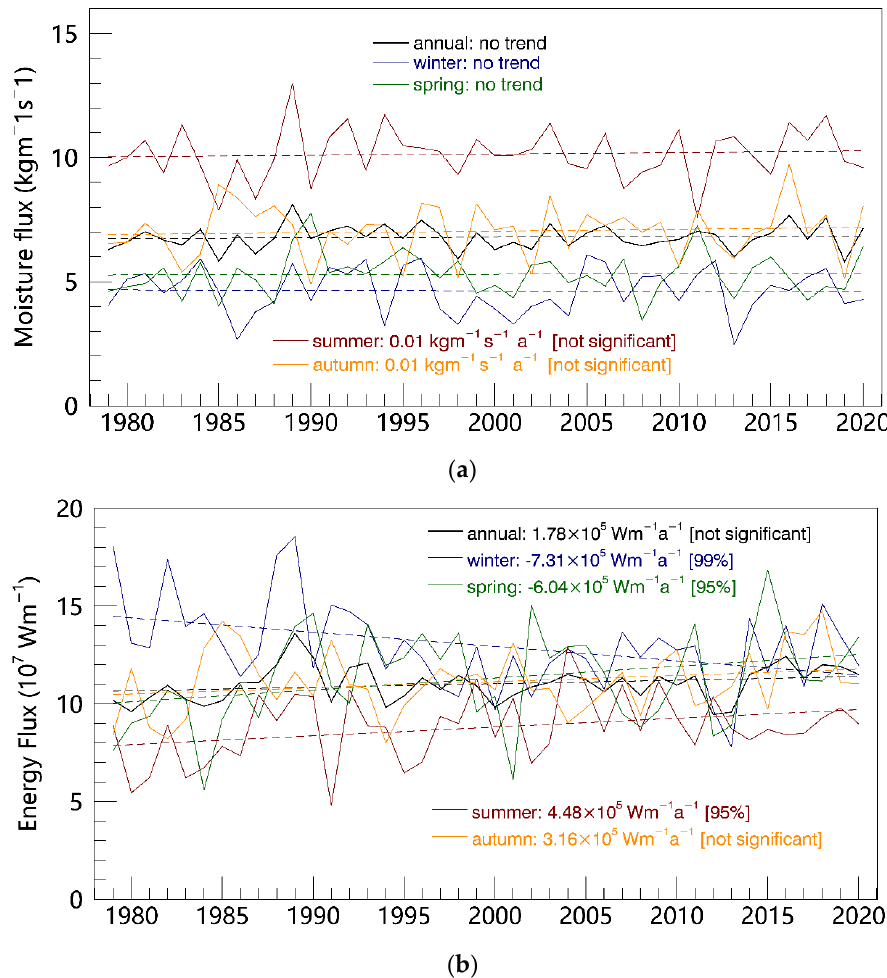
Figure 4. The series and trends of ( a ) meridional moisture flux and ( b ) energy flux across 70° N from 1979 to 2020. The record was obtained from the ERA5 dataset.